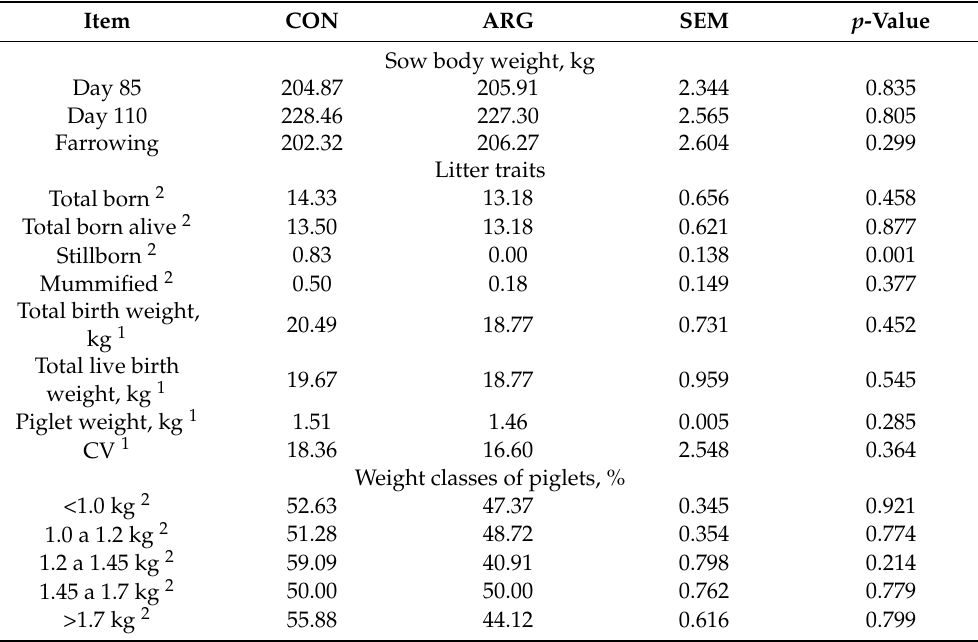
Table 3. Phenotypic data of sows ( n = 23) fed CON or ARG diets and